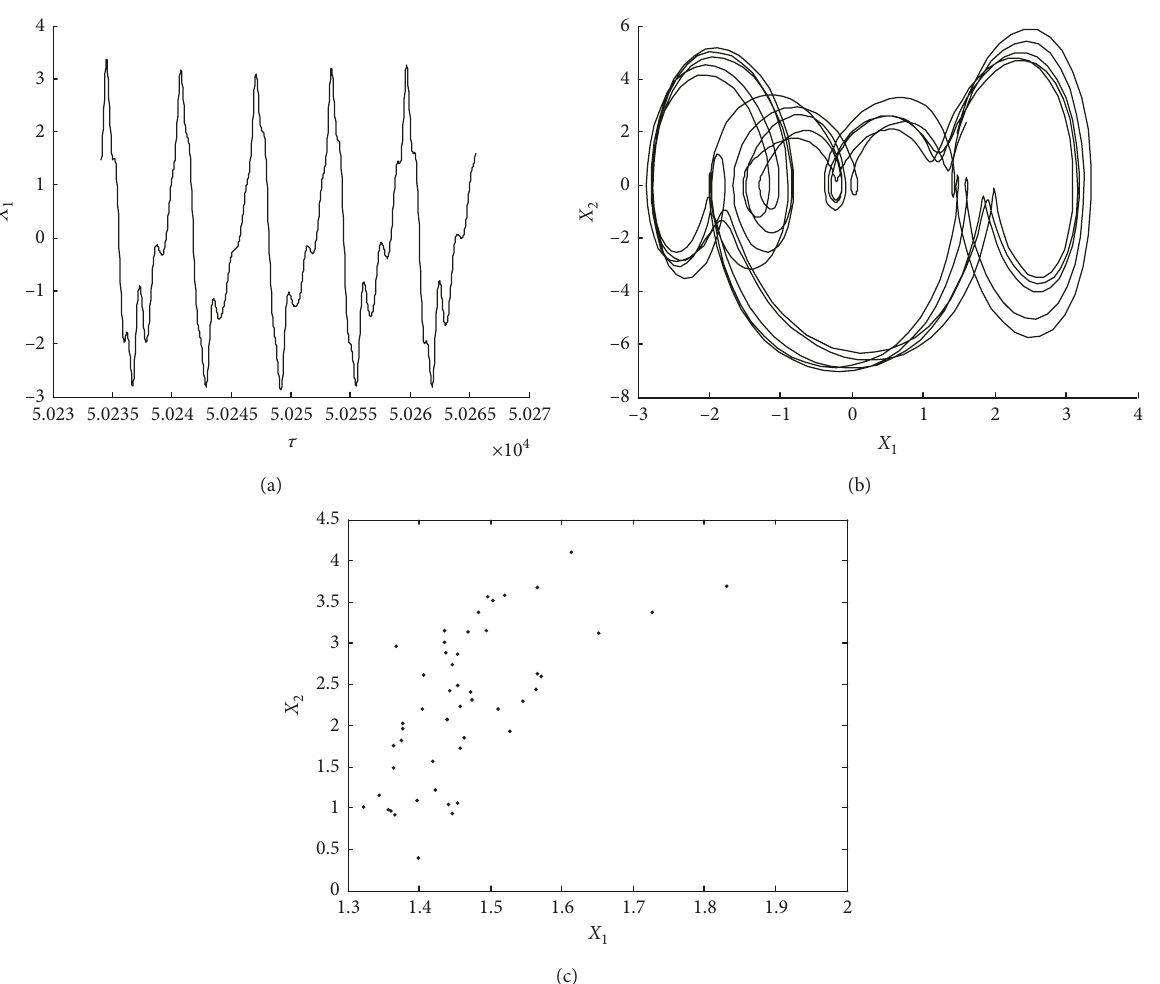
Figure 7: The chaotic motion ( Ω � 2, ω � 1, c � 0.1, r � 0.5, p � 10, c Poincar´e